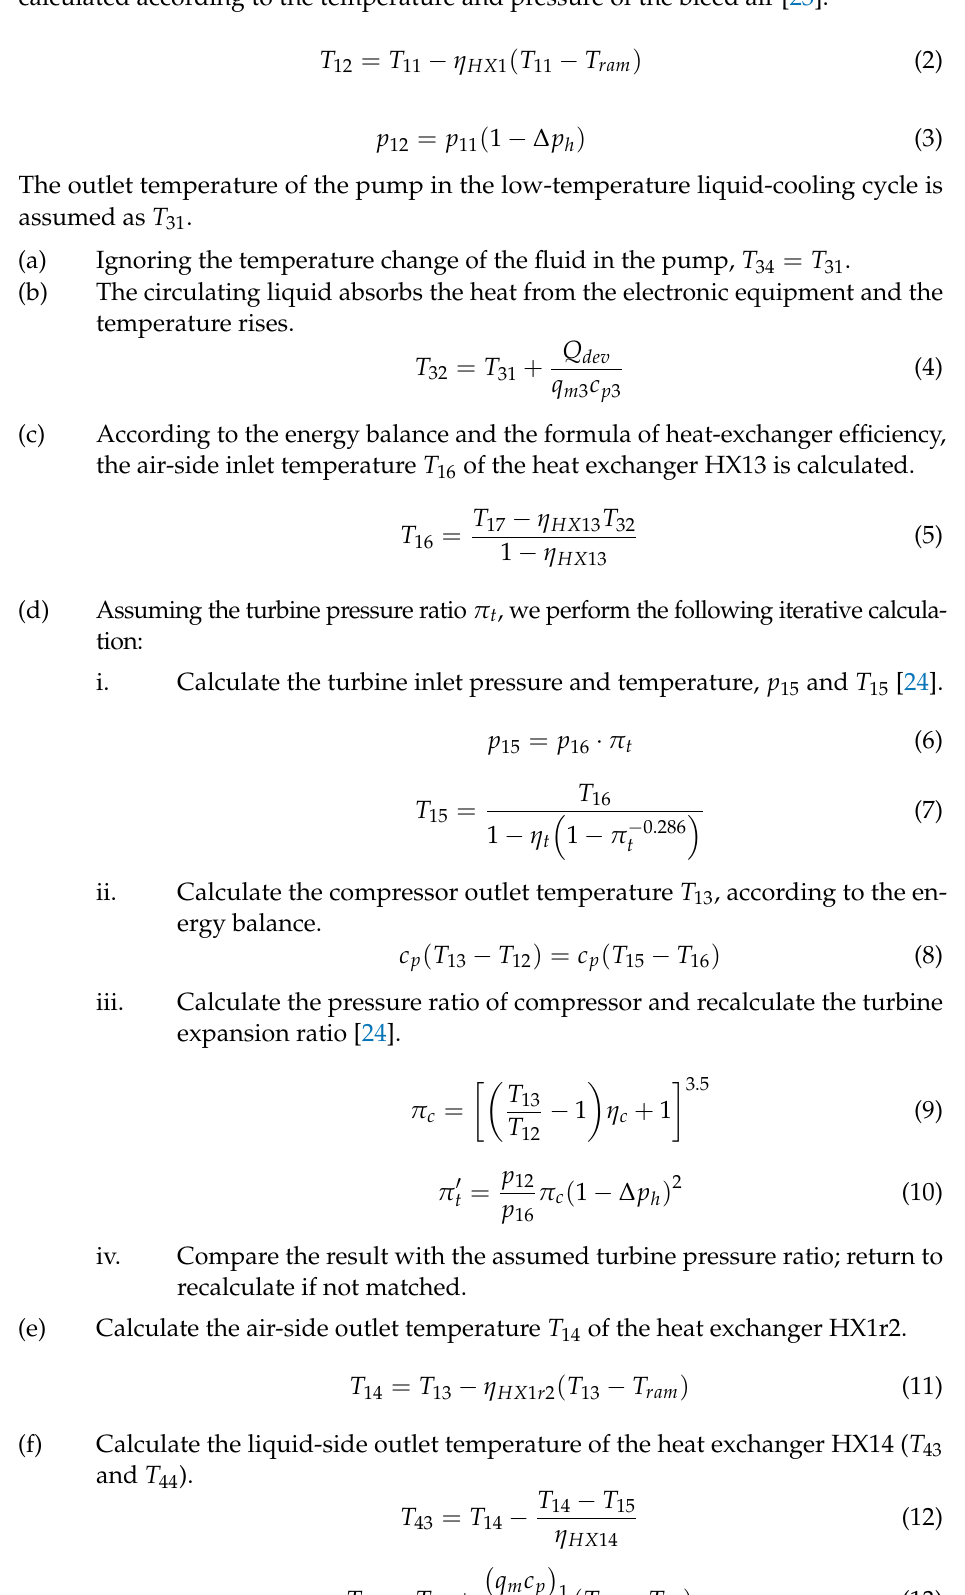
2. The outlet temperature and pressure of the heat exchanger HX1r1 ( T 12 and p 12 ) are calculated according to the temperature and pressure of the bleed air [23].